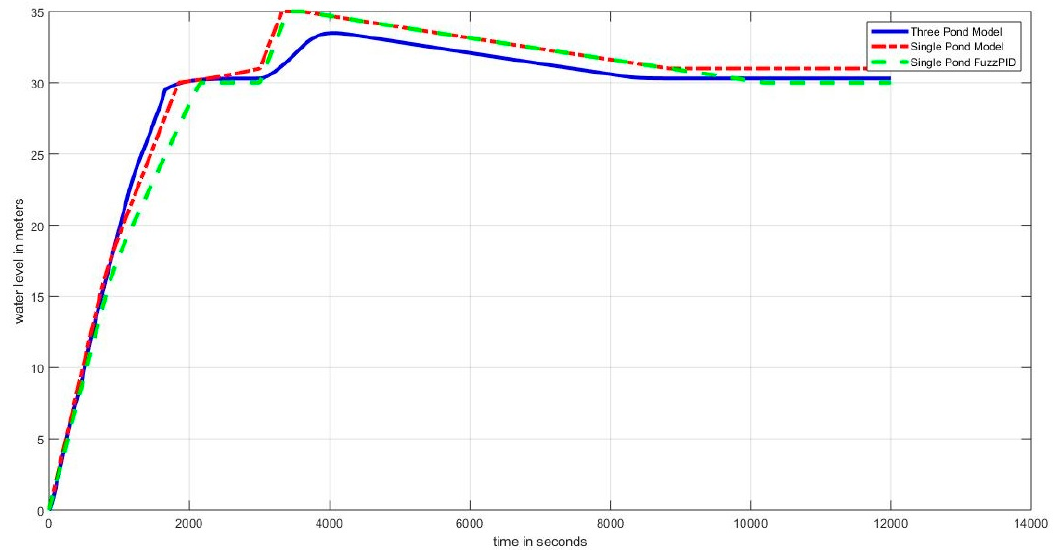
Figure 25. Comparison between the traditional (Fuzzy, FuzzyPID) system and the proposed system (positive surge).